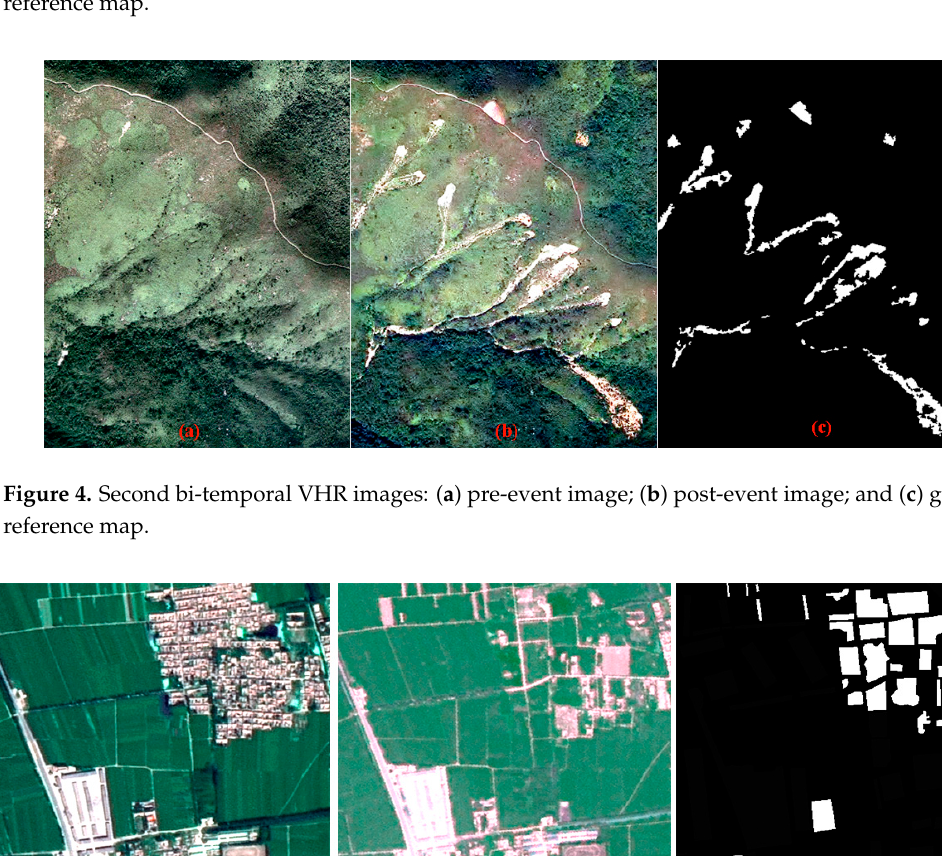
Figure 5. Third bi-temporal VHR images: ( a ) pre-event image; ( b ) post-event image; and ( c ) ground reference map.